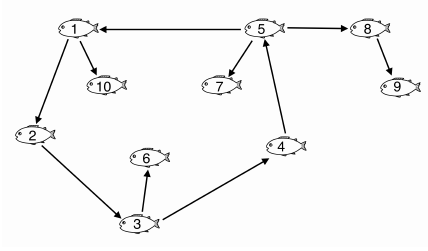
Fig. 8. Simple fish school model.